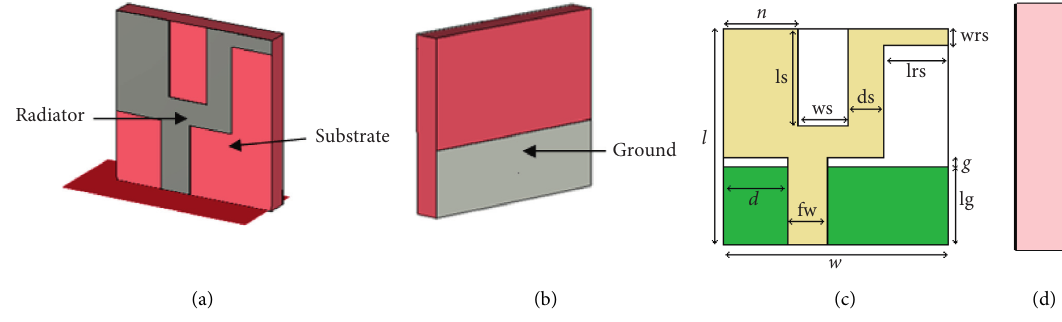
Figure 1: (a) Perspective front view; (b) perspective back view; (c) antenna dimensions; (d) left view. Table 1: Antenna parts and materials.